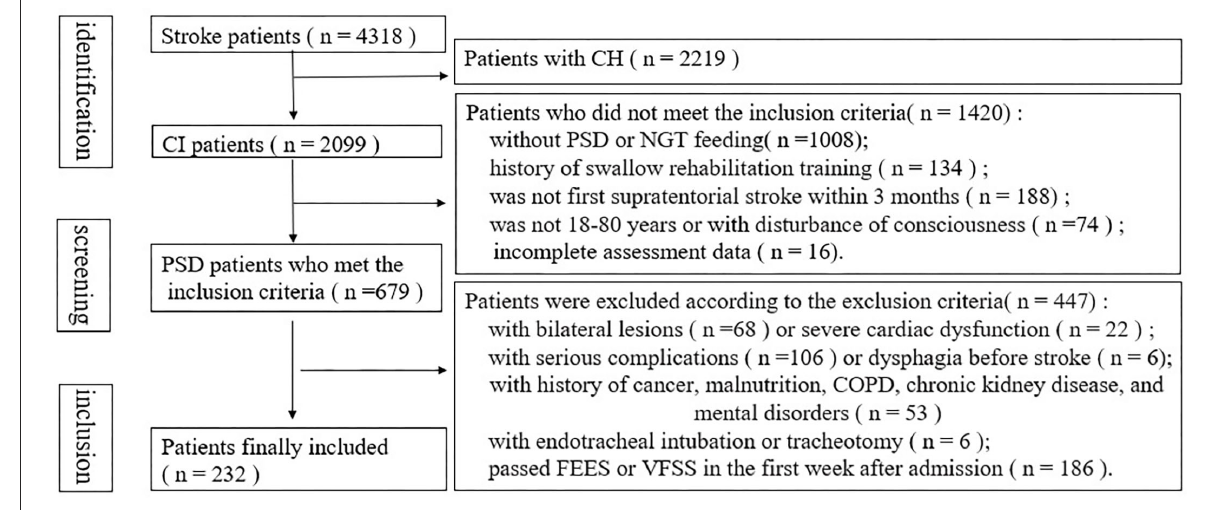
4,318 patients with PSD, 679 with NGT were